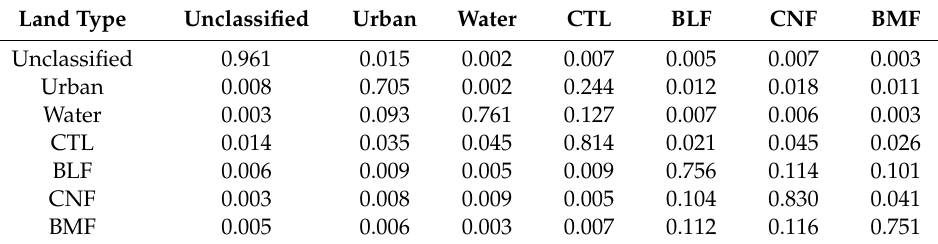
Table 5. The ATPM of four probability matrices in four stages.